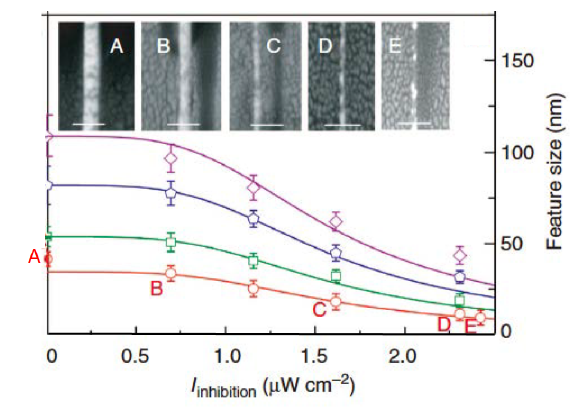
Figure 9: Dependence of the feature size of free-standing polymer lines written by RAPID lithography on the intensity of the doughnut- shaped deactivation beam. Insets show SEM images of points A, B, C, D, and E (scale bar: 100 nm) [63]. Reproduced with permission from Nature Publishing Group, © 2013 by Nature Publishing Group.